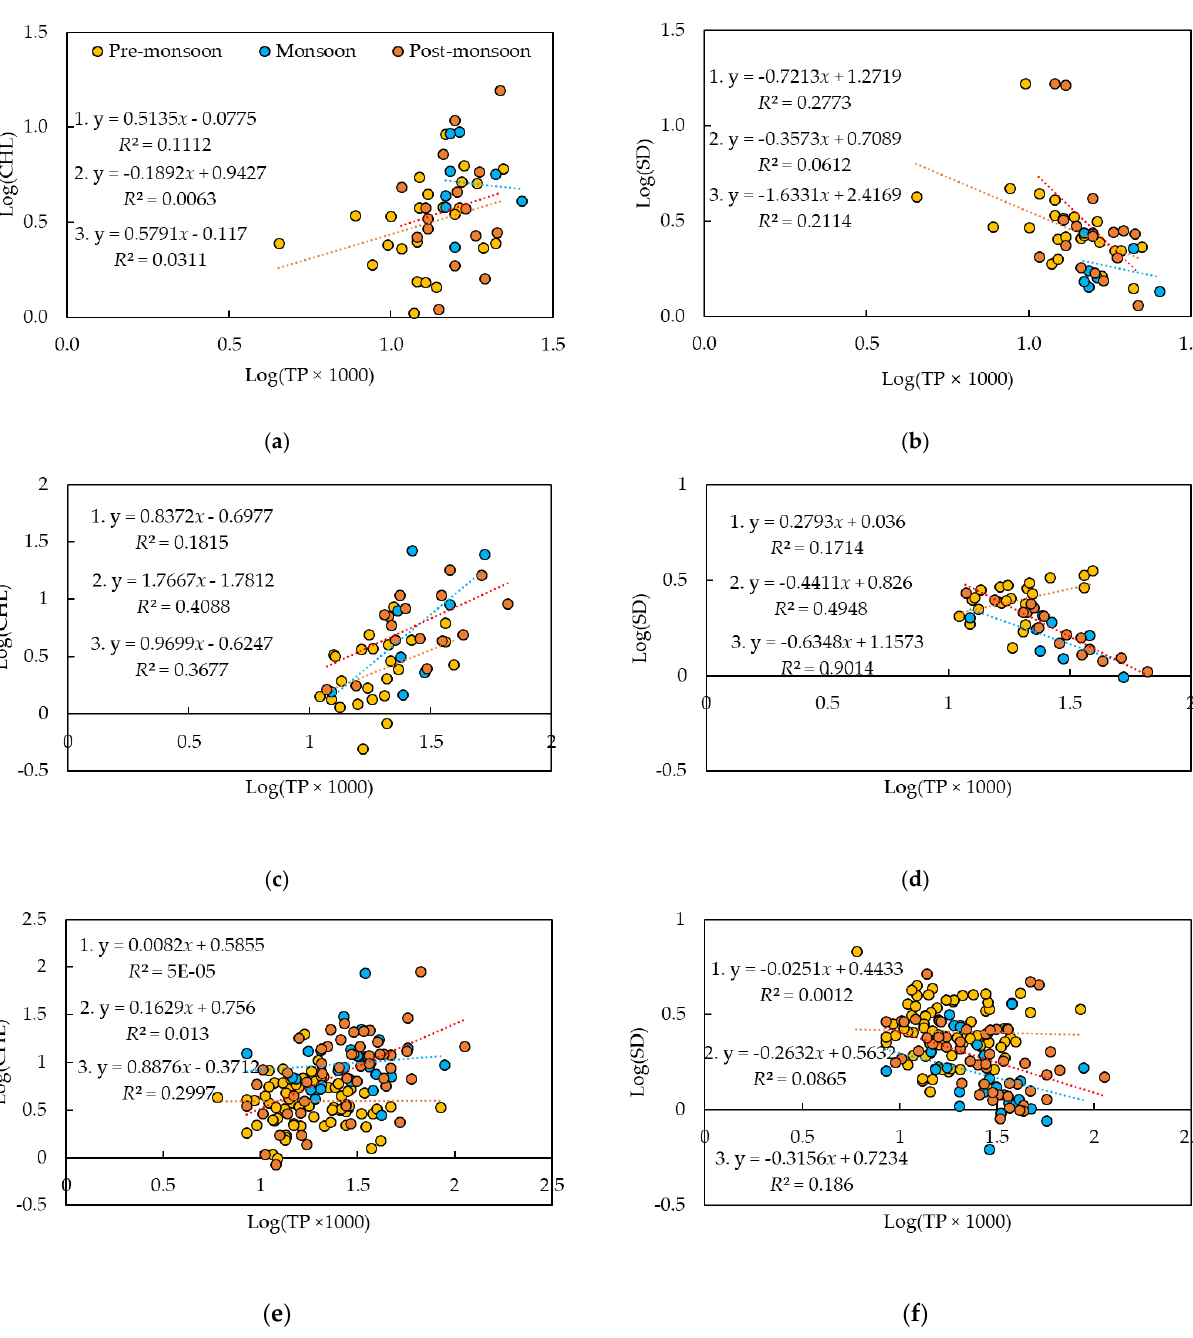
Figure 6. Empirical relationships between chlorophyll- a (Chl- a ), Secchi depth (SD), and total phosphorus (TP) in the three precipitation year groups. ( a ) Log(Chl- a )-Log(TP × 1000) and ( b ) Log(SD)-Log(TP × 1000) in the drought years; ( c ) Log(Chl- a )-Log(TP × 1000) and ( d ) Log(SD)-Log(TP × 1000) in the flood years; and ( e ) Log(Chl- a )-Log(TP × 1000) and ( f ) Log(SD)-Log(TP × 1000) in the normal years. The results for the regression equations in the figures are: 1. Pre-monsoon season; 2. monsoon season; and 3. post-monsoon season.